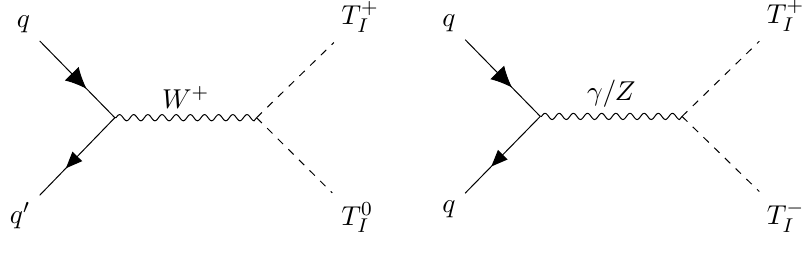
Figure 14 . Pair production of SU(2) adjoint